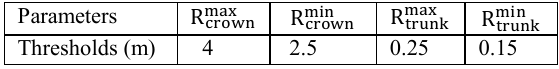
Table 1: Thresholds of parameters used for test site.